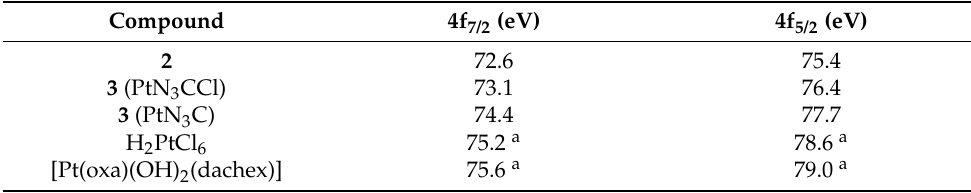
Figure 5. 1 H NMR of 3 in CD 2 Cl 2 at 293 K. Solvent peaks are identified by solid dot (CHDCl 2 ) or star (H 2 O). Peak integrations in green. Protons, except N-H, are omitted for clarity. Inset: Ball-and-stick diagram of 3 with proton labels. Table 2. Electron binding energies for 2 , 3, and two Pt IV